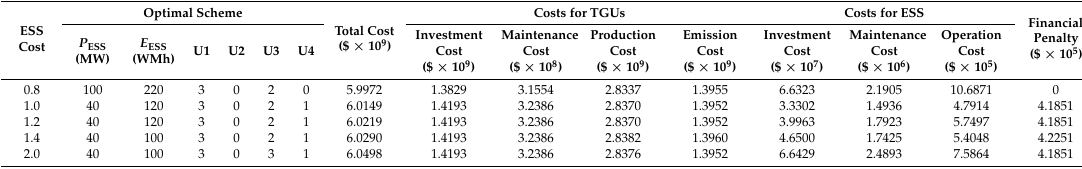
Table 9. Results on the effect of ESS